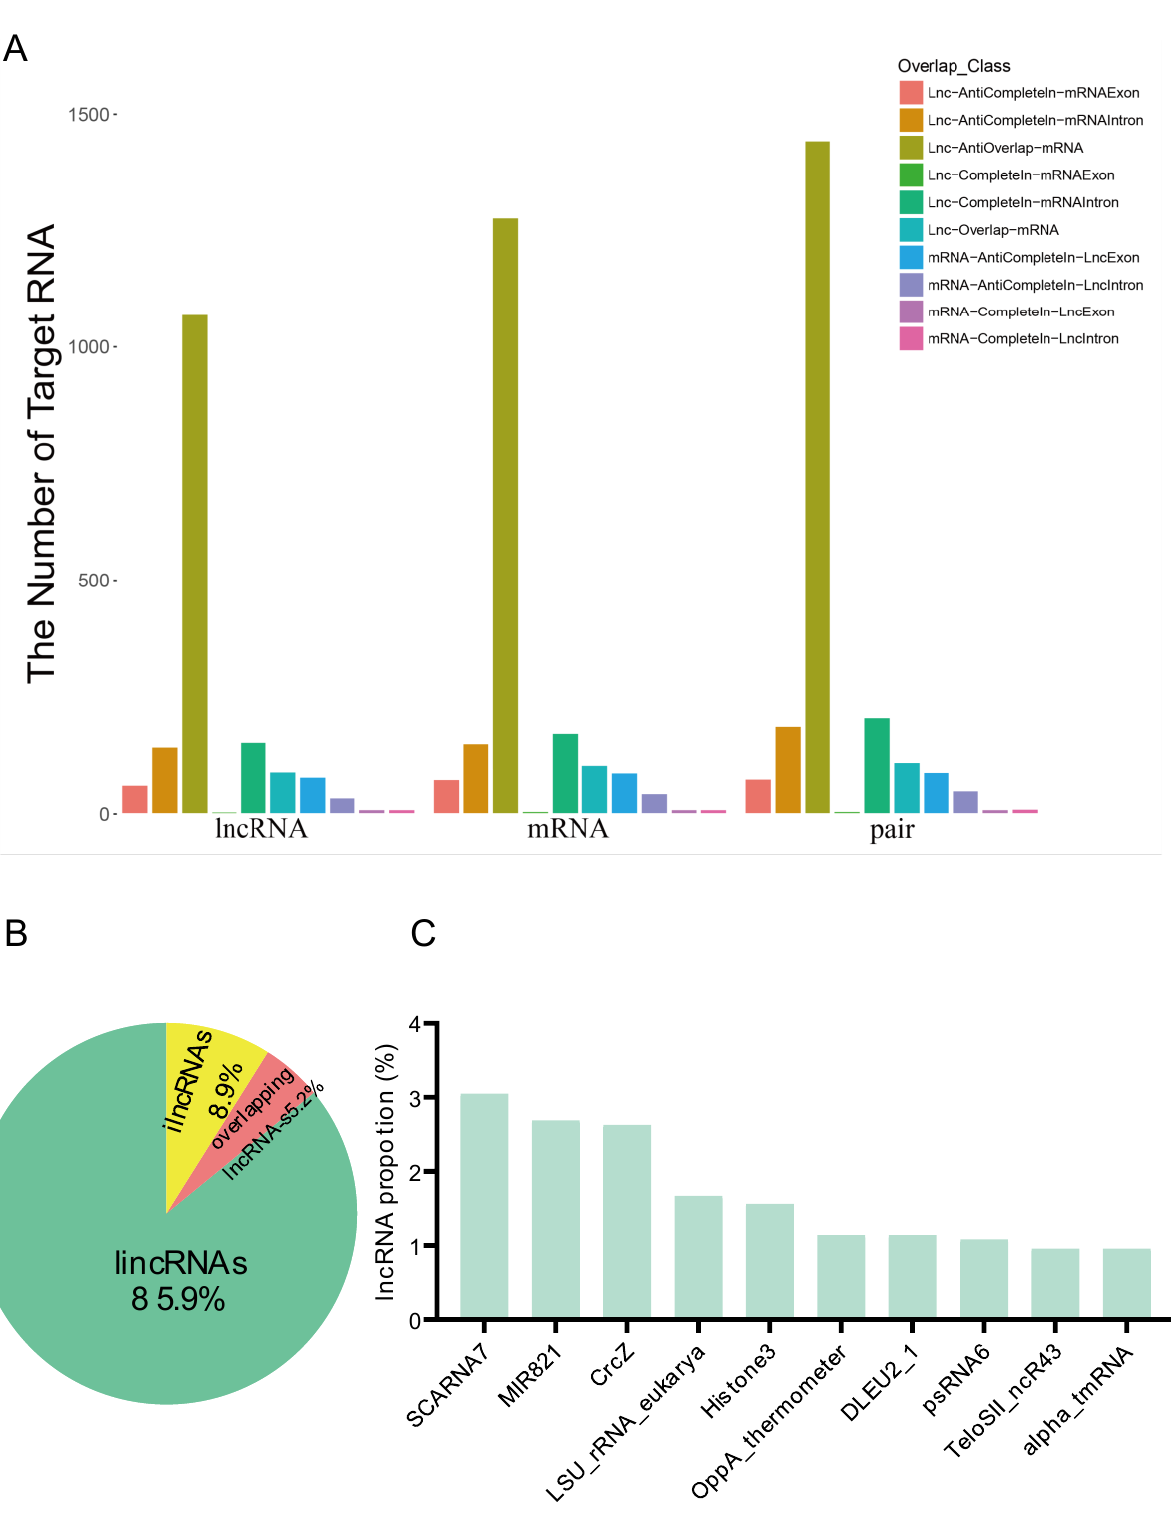
Figure 4. Statistical histogram of the overlapping classifications between the lncRNAs and the mRNA targets ( A ). ( B ) The proportional distribution of the lncRNAs in genomic location and context, where lincRNAs indicates intergenic lncRNAs (85.9%), ilncRNAs indicates intronic lncRNAs (8.9%), and overlapping lncRNAs include sense and antisense lncRNAs (5.2%). ( C ) The top 10 families of lncRNAs in T. castaneum , where the X-axis stands for the different families of lncRNAs.